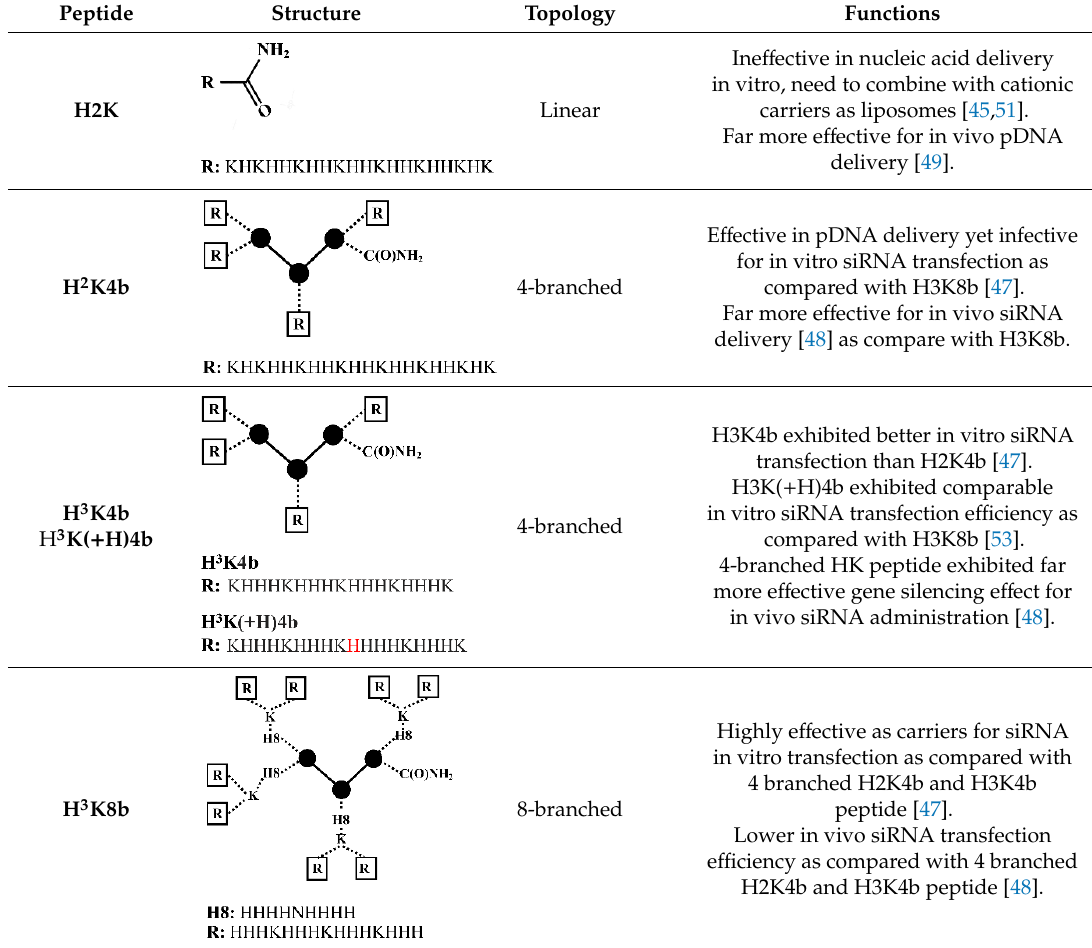
Table 2. Representative linear and branched HK peptides.